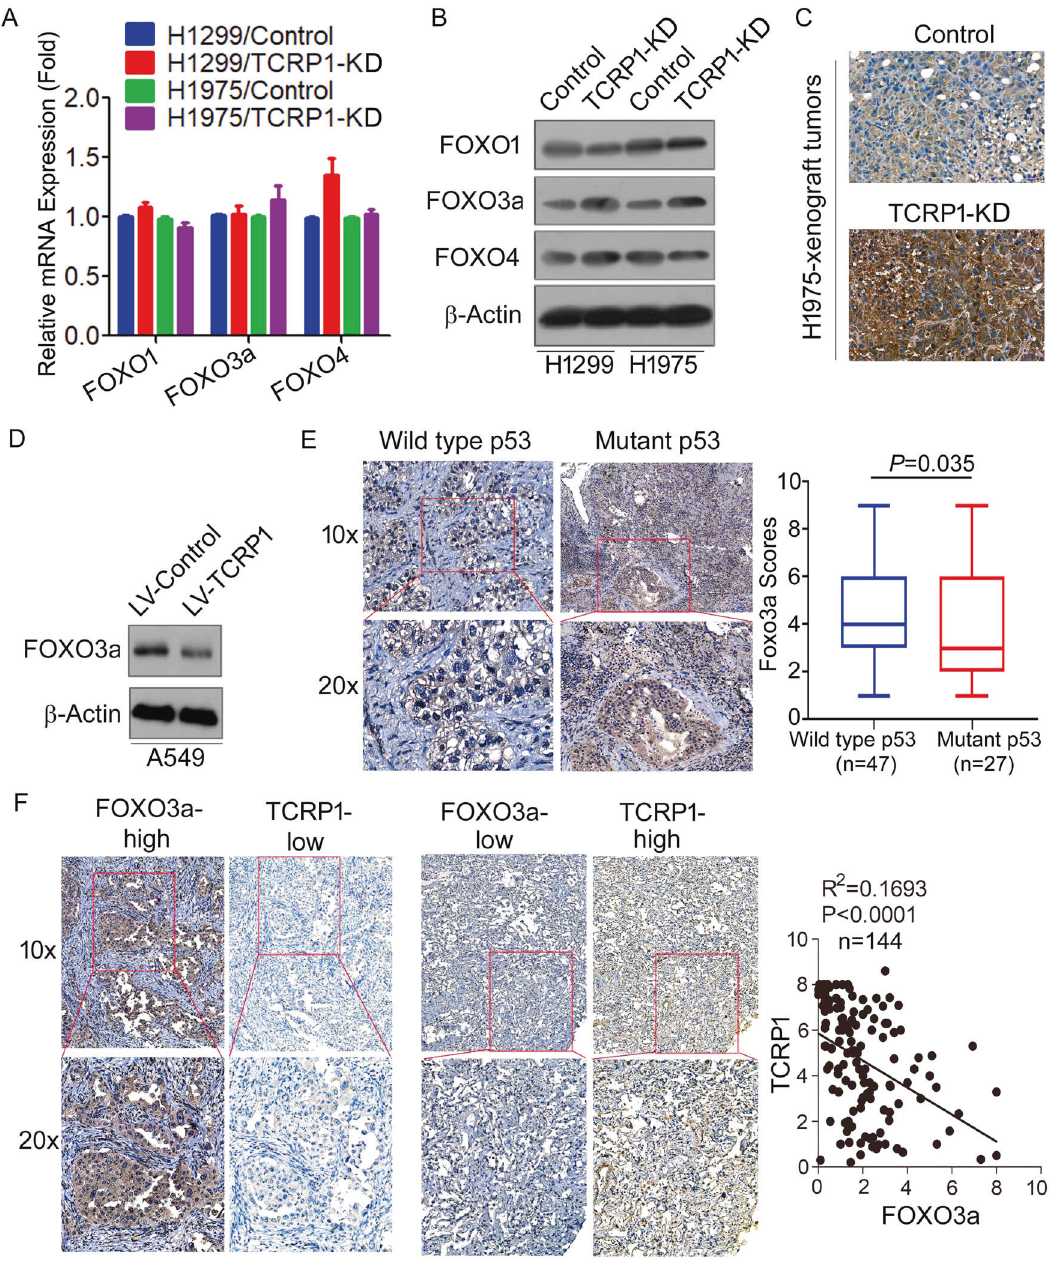
Fig. 5 TCRP1 downregulated the protein level of FOXO3a. In H1299 cells and H1975 cells with knocking down TCRP1 and each control cells, qRT-PCR ( A ) and western blot assays ( B ) were utilized to detect the expression of FOXO transcription factors in these cells. C The levels of FOXO3a in tumors drove by H1975 cells with reducing TCRP1 and control groups were estimated by IHC assays. D The protein levels of FOXO3a in A549 cells with restoring TCRP1 and control cells were estimated by western blot assays. E IHC assays were implemented to evaluate FOXO3a expression in 74 cases of NSCLC tissues basing on wild type p53 or mutant p53. F The expression levels of TCRP1 and FOXO3a in 144 cases of NSCLC tissues were estimated via IHC assays. The expression relationship between TCRP1 and FOXO3a was analyzed by Pearson correlation